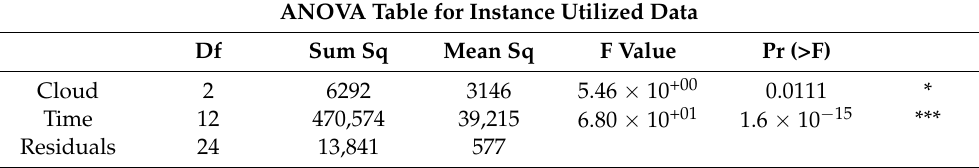
Table 4. ANOVA Table for instance Lang. UUID .